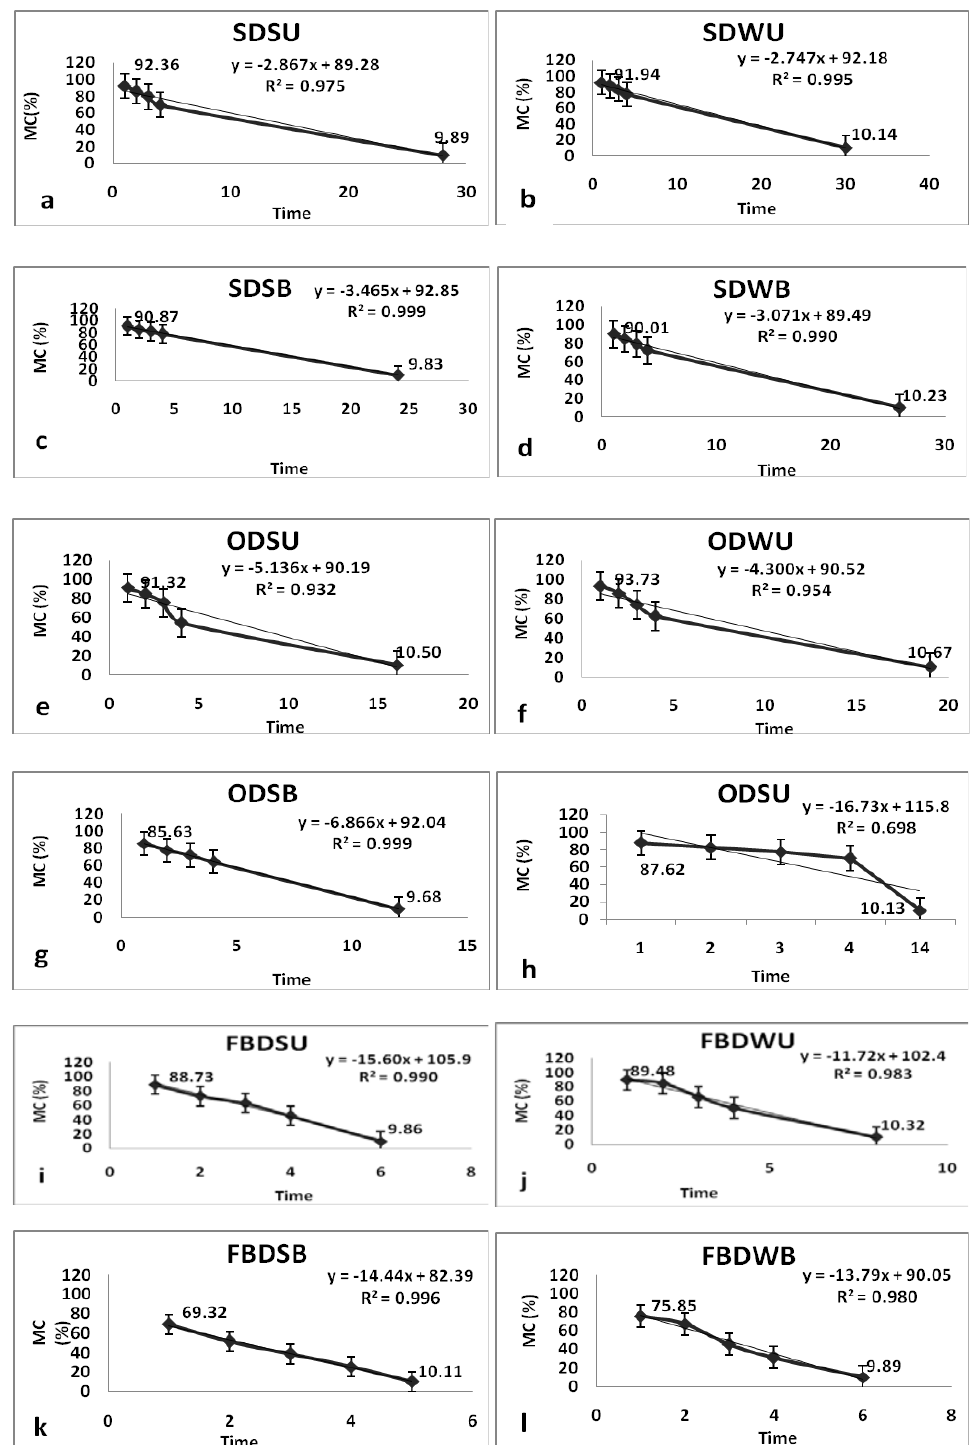
Figure 1. ( a – l ): Variation in moisture content of Turmeric with drying time. (SDSB: Sun Dry Slice Boiled, SDWB: Sundry whole boiled, SDSU: Sundry sliced unboiled, SDWU: Sundry whole unboiled, ODSB: Oven dry sliced boiled, ODSU: Oven dry sliced unboiled, ODWB: Oven dry whole boiled, ODWU: Oven dry whole unboiled, FBDSB: Fluidized bed dry sliced boiled, FBDSU: Fluidized bed dry sliced unboiled, FBDWB: Fluidized bed dry whole boiled, FBDWU: Fluidized bed dry whole unboiled).